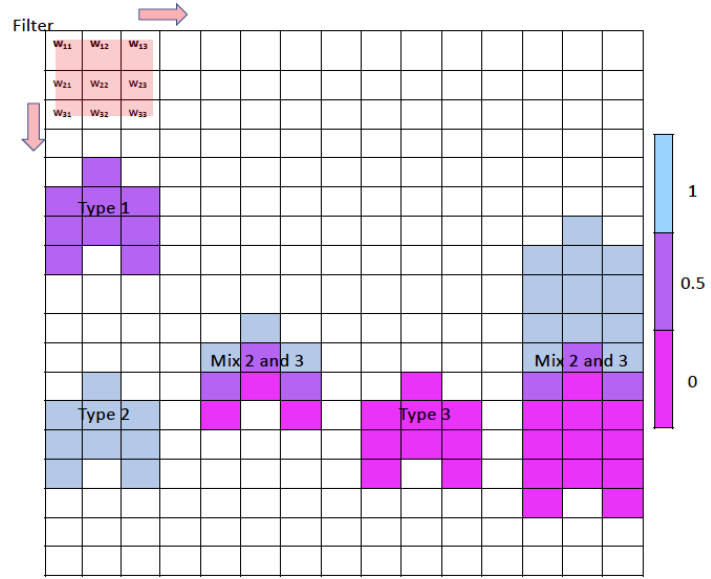
Figure 1. Schematic texture information in the role of classification. Vertically adjacent colored grid cells represent layers identified by the COSCAs. The colors of the grid cells indicate feature types, i.e., feature type 1 is shown in purple, type 2 in blue, and type 3 in magenta. In this example, some COSCA layers (e.g., on the far right) are seen to comprise a mix of different feature types.